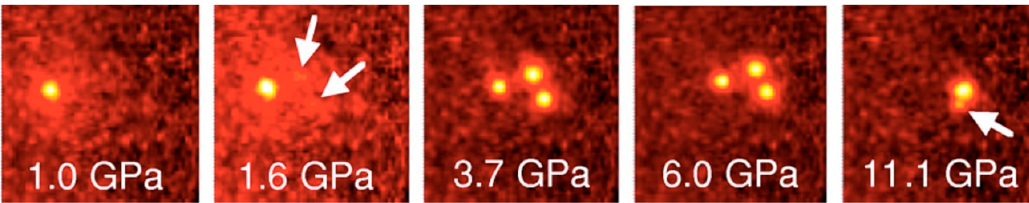
Figure 3. In situ diffraction experiment on a Na 0.5 Bi 0.5 TiO 3 single-crystal shows changes in 300 reflections as a function of applied pressure. Symmetry-related peak splitting indicates gradual cross-over from rhombohedral-to-monoclinic-to-tetragonal phases with increasing applied pressure. The arrows indicate the appearance of additional peaks. After Kreisel et al. Reprinted from reference [45] DOI: 10.1103/PhysRevB.68.014113, with permission from the American Physical Society.